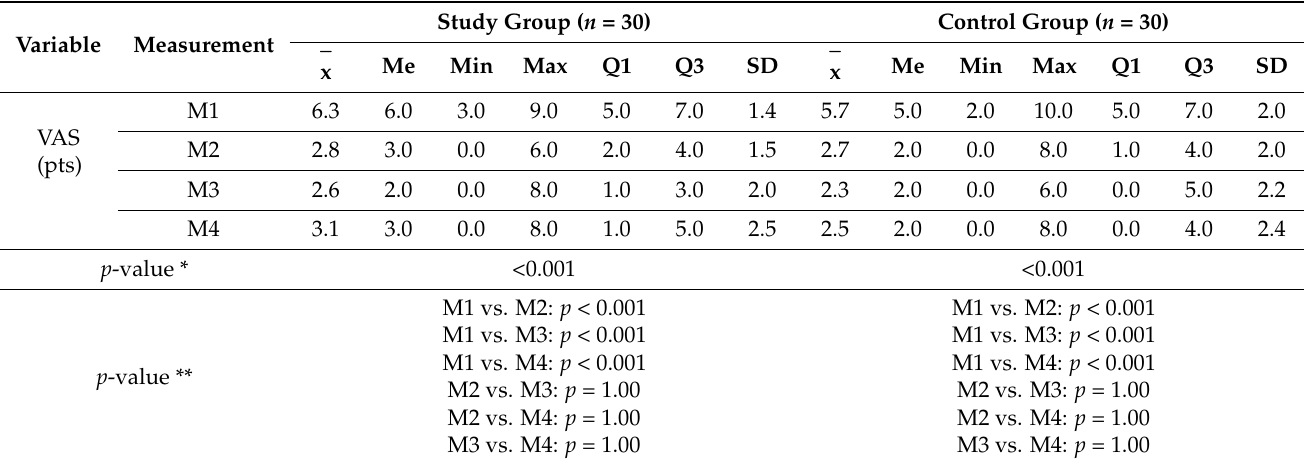
Table 2. The comparison of changes in pain scores (VAS) between the study and control group. Study Group ( n = 30) Control Group ( n = Variable Measurement